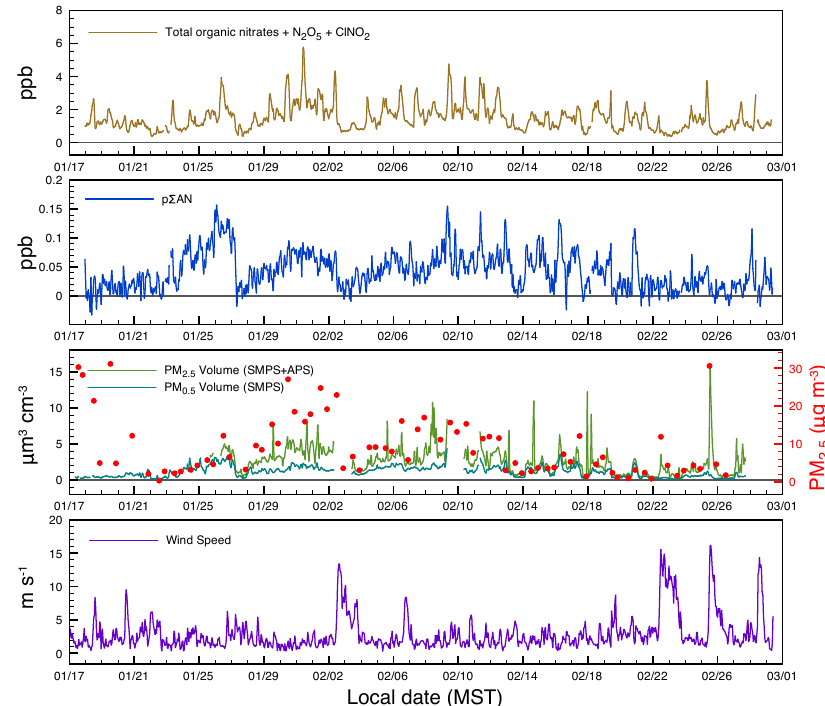
Figure 1. Hourly time series from measurements of total organic nitrates plus N 2 O 5 and ClNO 2 , particulate organic nitrate ( p(cid:54) AN), and total aerosol volume measured by SMPS and APS with filter-sampled PM 2 . 5 mass (red dots, secondary axis) and local wind